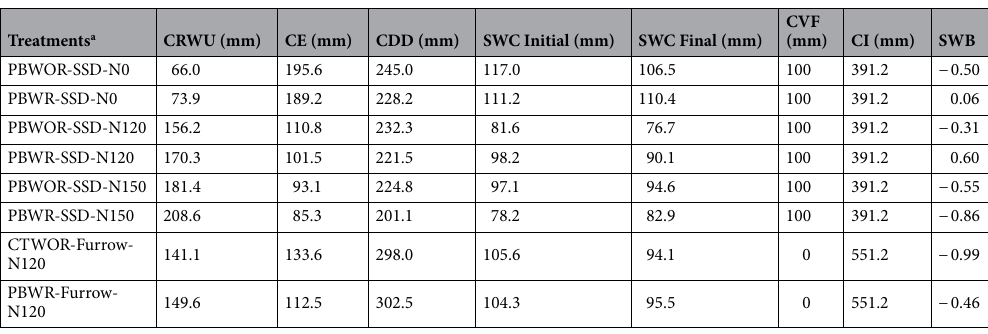
Table 1. Soil water balance (SWB) components computed by using HYDRUS-2D for simulation period (8–89 DAS) of maize. CRWU: cumulative root water uptake; CE: cumulative evaporation; CDD: cumulative deep drainage; SWC Initial: Initial (on the first day of simulation) cumulative soil–water content (mm) in soil profile up to 45 cm depth; SWC Final: Total soil water content in 45 cm depth of soil on the last day (82th) of simulation; CVF: cumulative variable flux; CI: cumulative infiltration (rainfall + irrigation) for treatments with furrow irrigation and only rainfall for treatments with subsurface drip irrigation; SWB: soil water balance. a For treatment detail please see Table 4.